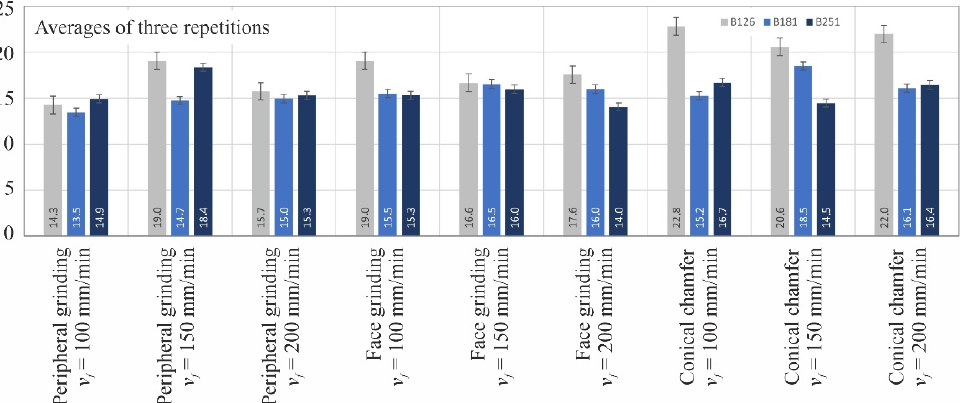
Figure 8. Average cutting force values determined from measurements of three blades shaped with the same grinding process parameters using grinding wheels with cBN abrasive grains B126, B181 and B251 (error bars represent the standard error equal to the standard deviation σ divided by the square root of the total number of samples).